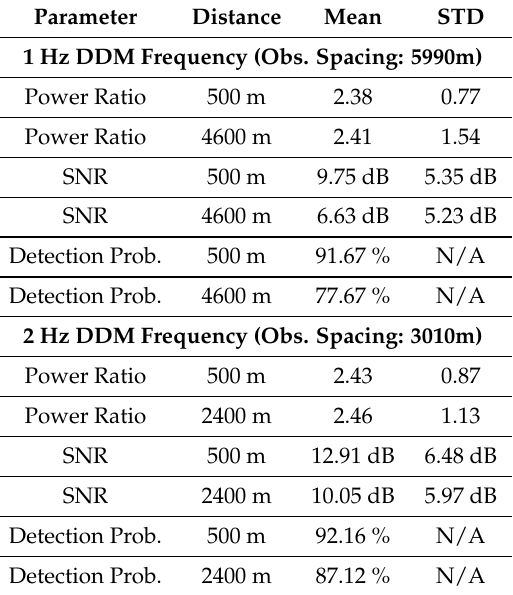
Table 4. Observation statistics and estimated LSQ fit of coherence detection threshold distances (4600 m at 1 Hz, and 2400 m at 2 Hz) for 1 Hz and 2 Hz DDM